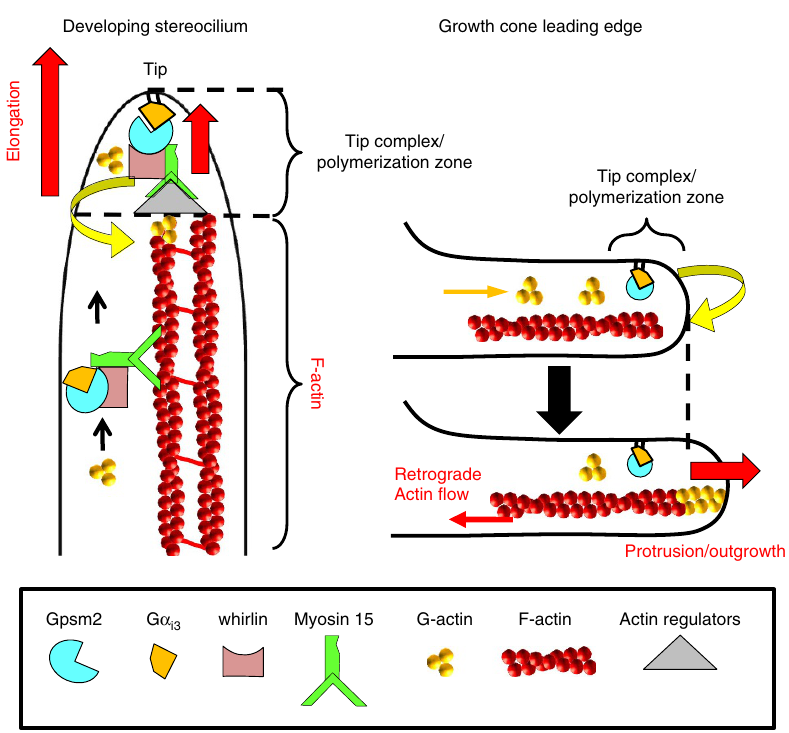
Figure 9 | Gpsm2 mutations affect stereocilia elongation and neuronal outgrowth by regulating actin dynamics at tip complexes. Mechanistic model for Gpsm2-dependent stereocilia elongation and neuronal outgrowth. Gpsm2 accumulates at the tip complex of both structures via the myosin 15 motor protein in stereocilia and a comparable motor protein in filopodia. Gpsm2-dependent macromolecular protein complexes modulate actin dynamics at the tip of stereocilia (growing end) or the leading edge of the growth cone, participating respectively in the elongation and motility of the two structures. See text for details.